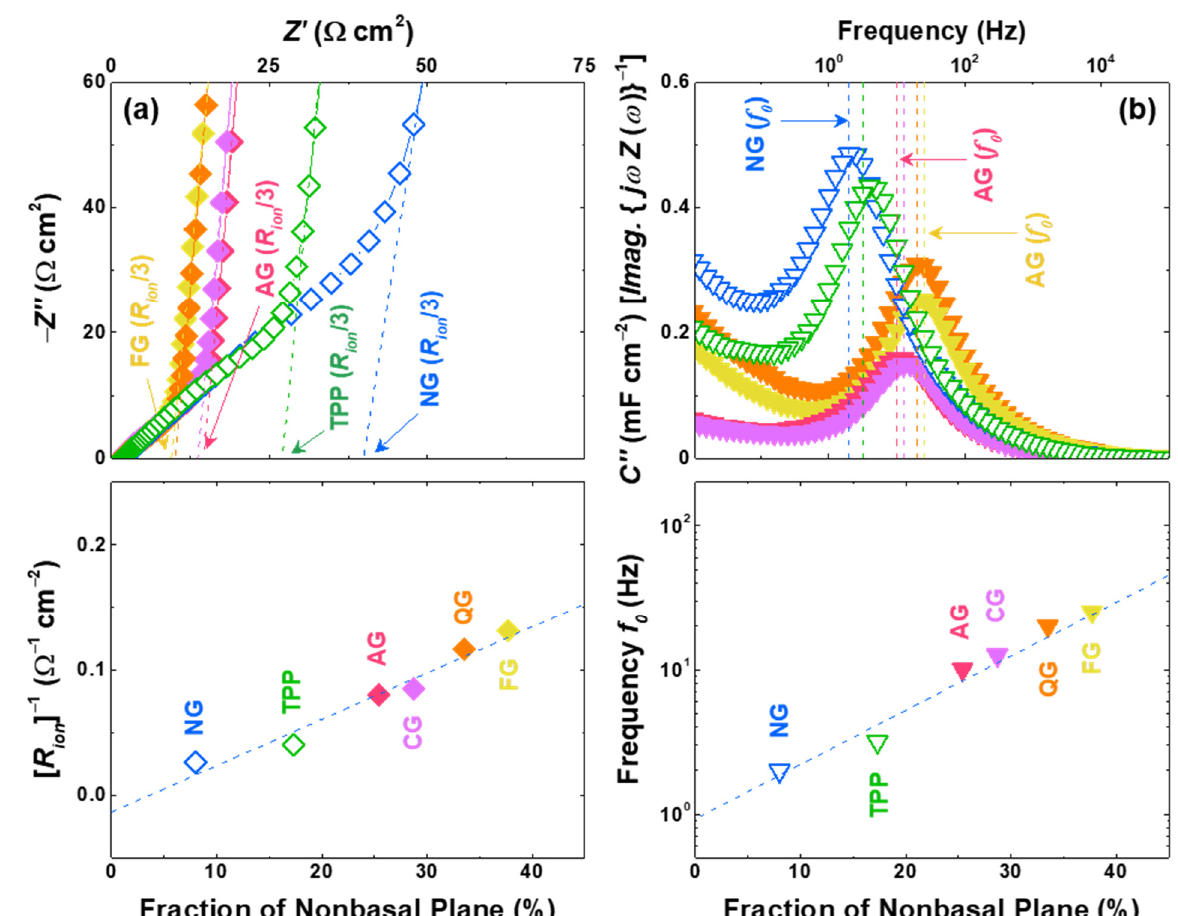
Figure 4. Kinetic properties of graphite symmetric electrodes. ( a ) Impedance spectra at the pristine state (before lithiation) where the intercept at the x -axis indicates ionic resistance ( R ion /3) in a porous electrode (top). Dependence of the fraction of non-basal planes on the inverse of the ionic resistance ( R ion ) −1 (bottom). ( b ) Imaginary part of complex capacitance (top) where the dashed line indicates the frequency for the maximum value ( f 0 ). Dependence of the fraction of non-basal planes on the Li-ion response frequency ( f 0 ) (bottom).